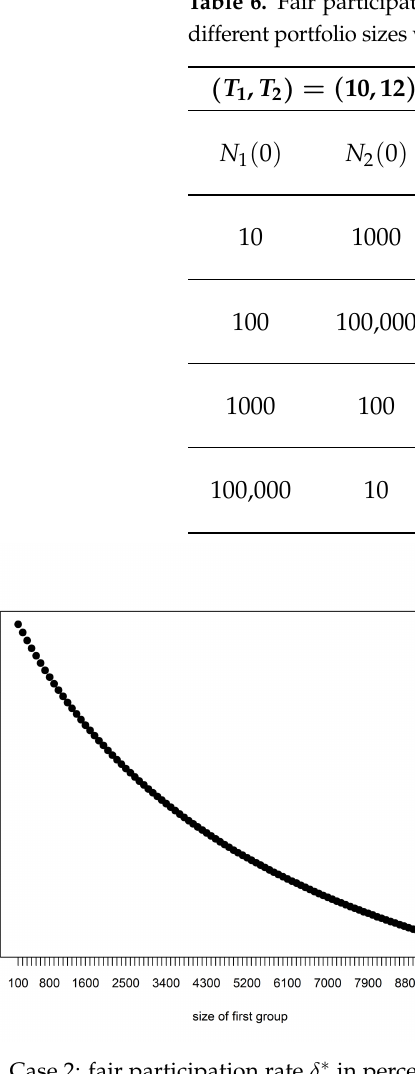
Figure 3. Case 2: fair participation rate δ ∗ in percentage ( left ), assets’ and liability’s values ( right ) in terms of the size of 2 the first group when N 2 ( 0 ) = 3000 and E Q [ ∆ ] = 0.8. In the right-hand plot, total assets’ value W ( T 1 ) at T 1 (dark grey), outstanding liability for the first group L 1 ( T 1 ) at T 1 (light grey) and assets’ value W (cid:48) ( T 2 ) at T 2 (black) are